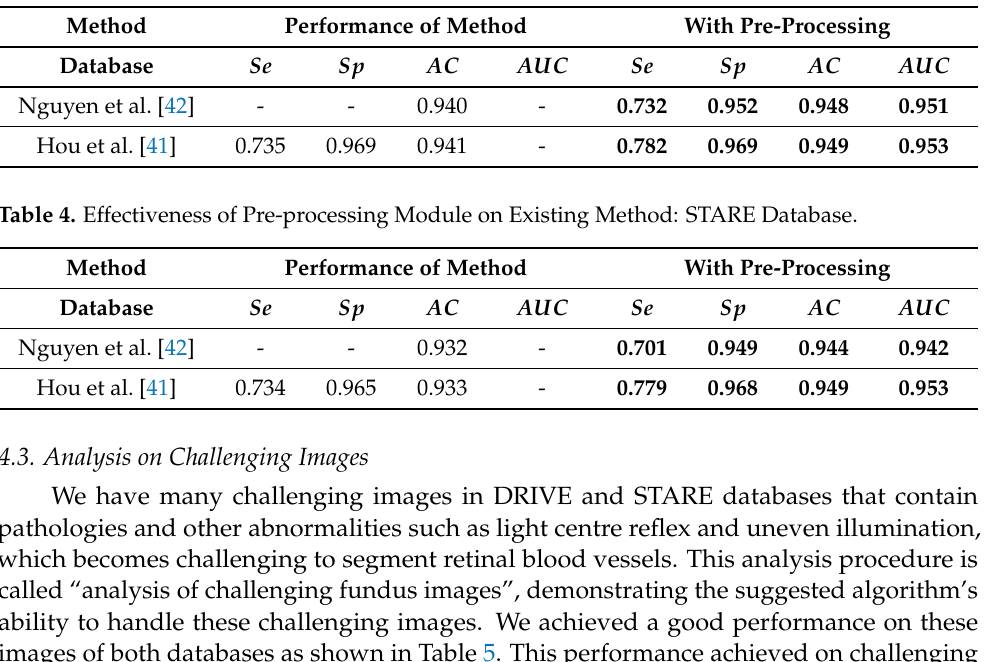
Table 3. Effectiveness of Pre-processing Module on Existing Method: DRIVE Database.